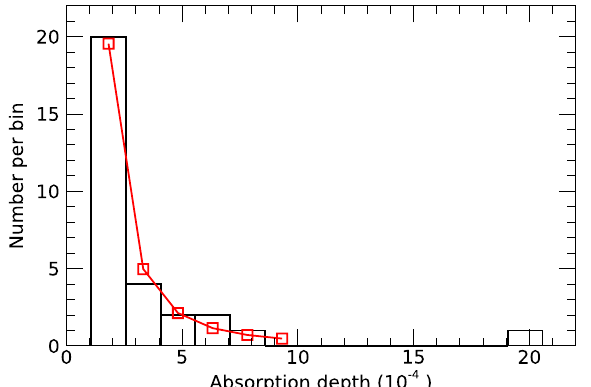
Figure 1. Histogram of the number of exocomet transit events as a function of the absorption depth. The red line shows the fit with a power law function with α = 2.3 ± 0.4 . The uncertainty on the fitted parameters of the power law function have been evaluated using a Poisson distribution for the number of events in each bin 4 of width dAD = 1.5 · 10 − . The red squares represents the number of expected events in each bin as calculated with the fitted power law.